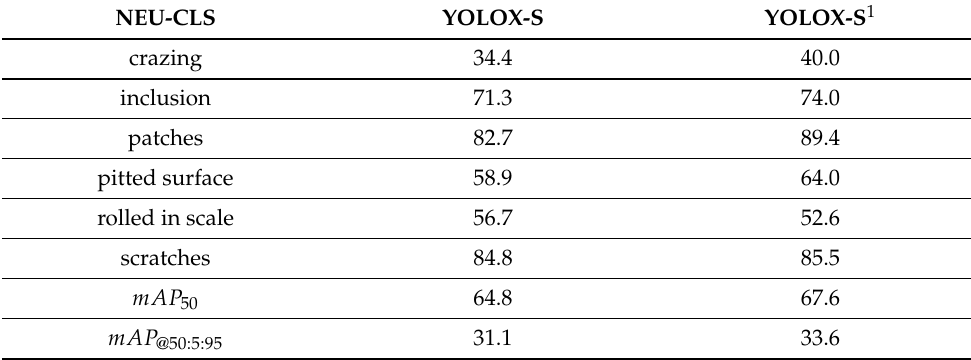
Table 7. Model detection results on the NEU-CLS